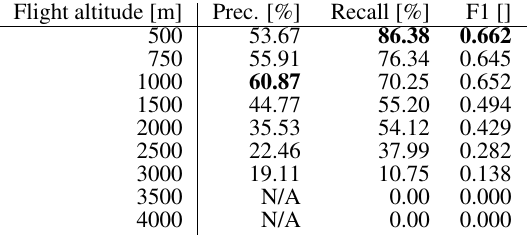
Table 3. Precision, recall, and F1-score of identified significant change for different flight altitudes, 66 h into the time series